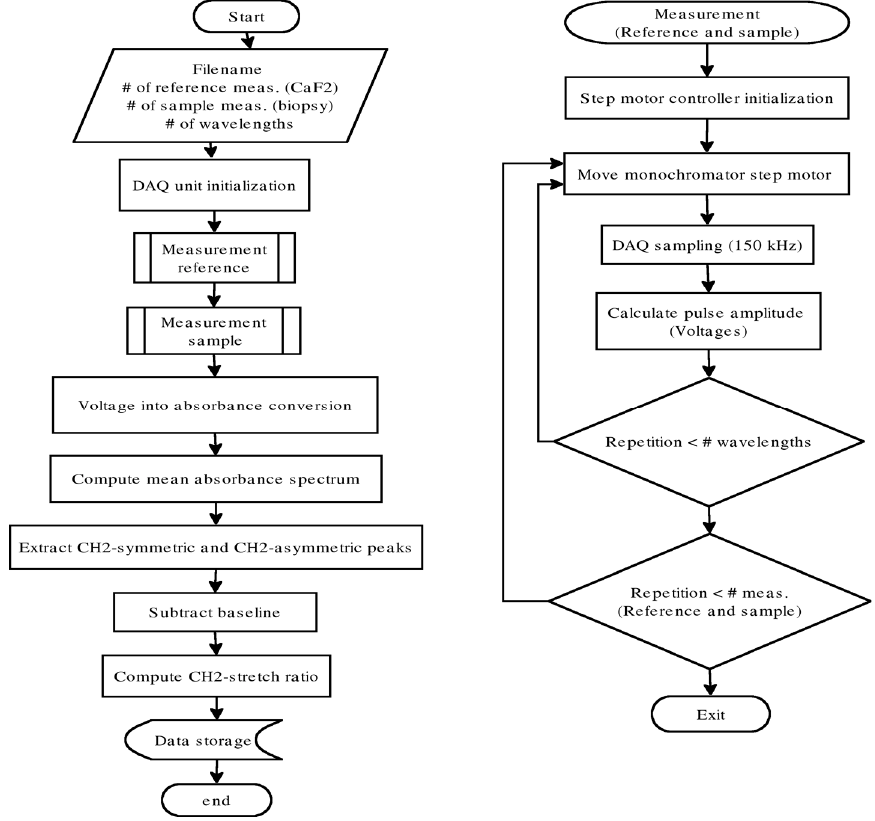
Figure A1. Flowchart of the MATLAB script structure. The flowchart is organized in two processes. The main process sets the user defined parameters, initializes the DAQ unit, performs the measurements, determines the IR absorbance spectrum and computes the CH 2 stretch ratio. The second process represents the measurement process driving the step motor of the monochromator, evaluating the pulse amplitude in voltage for each wavelength and for the user defined number of repetitions.